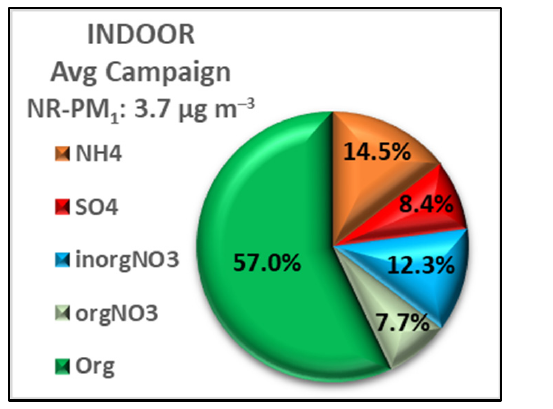
Figure 3. ( a , b ) Contributions of OVOCs (green), hydrocarbons and potential fragments of alcohols (C x H y , yellow) and others (light blue) to the observed pool of VOCs ( a ) outdoors and ( b ) indoors; ( c , d ) contributions of C x H y O (dark green), C x H y O 2 (light green) and C x H y O z ≥ 3 (white) compounds to the total pool of observed OVOCs ( c ) outdoors and ( d ) indoors. Values in parenthesis indicate the number of measured species. ( e , f ) Contribution of inorganic (NH 4 : orange, inorgNO 3 : light blue, orgNO 3 : light green, SO 4 : red) and organic (green) fractions to the total mass of NR-PM 1 particles ( e ) indoors and ( f ) outdoors.